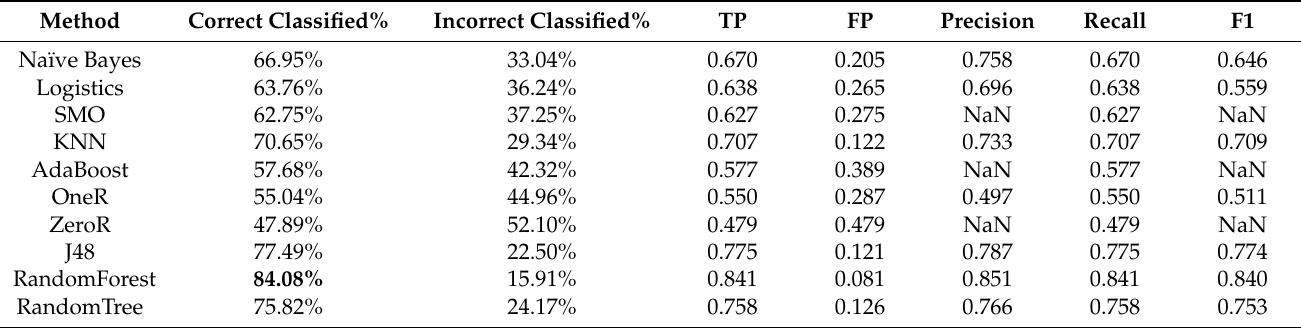
Table 11. Evaluation of multi-classification algorithms using GPS data.